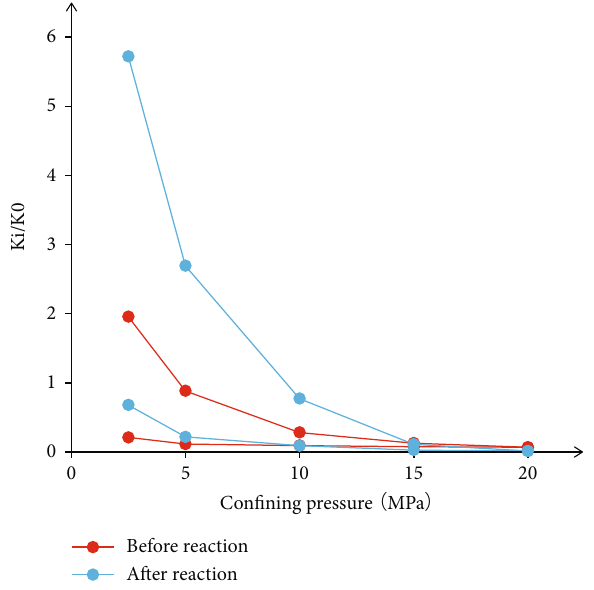
Figure 13: Stress sensitivity of shale before and after interaction with 5000mg/L NaCl solution for 24